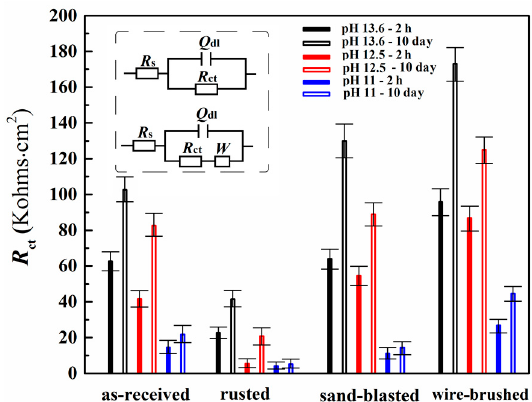
Figure 4. Fitted R t values of the rebar during passivation in SCPS of different alkalinity for 2 h and 10 days.